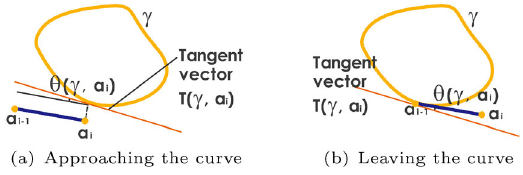
Fig. 6 Two different cases for tracing existing curves when modeling new